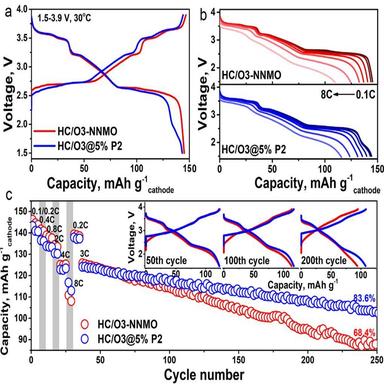
The cycling performance of HC/O3-NNMO and HC/O3@5% P2 full cells. (a) Initial charge/discharge curves of the full cells. (b) Discharge curves of HC/O3- NNMO and HC/O3@5% P2 full cells at different current rates from 0.1 to 8 C. (c) The rate capabilities and cycling stability of the full cells (insets: corresponding charge/discharge curves at 3C).